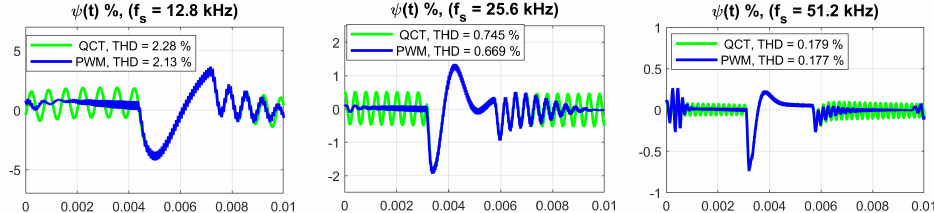
Figure 10. Distortion function ψ ( t ) on the QCT stability boarder ∆ A = 1.0 vs ψ ( t ) delivered by the PWM simulation model. The PWM system remains stable—the QCT stability criterion is